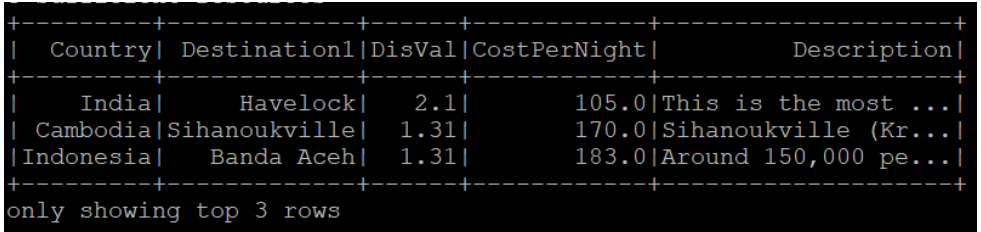
Figure 25. Example 1 of destination suggestions from thematic TRS.